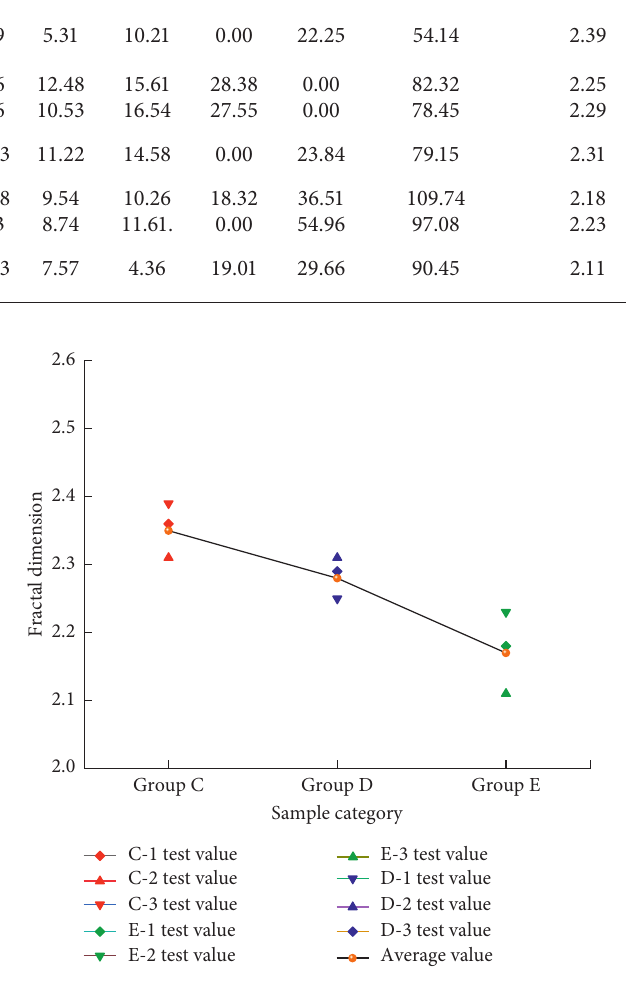
Figure 7: Fractal dimension characteristics of the combined